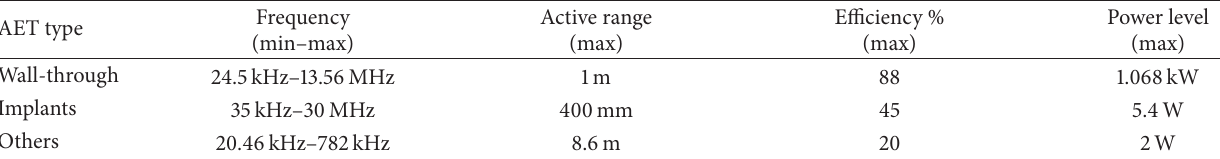
Table 2: Summary of the review.